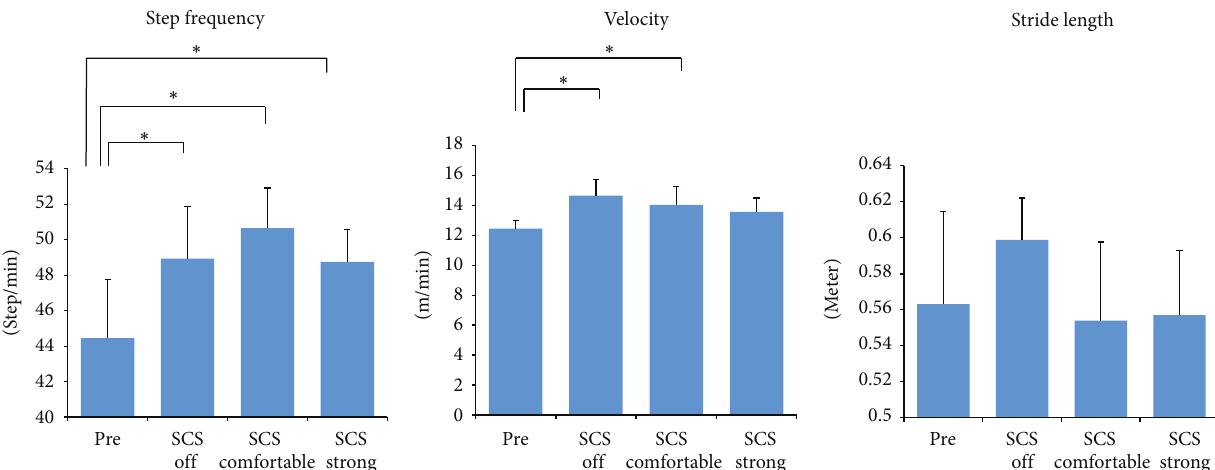
Figure 2: Mean values for step frequency, velocity, and stride length of the gait. The error bars represent one standard deviation. The asterisks indicate significant difference ( 𝑝 < 0.01